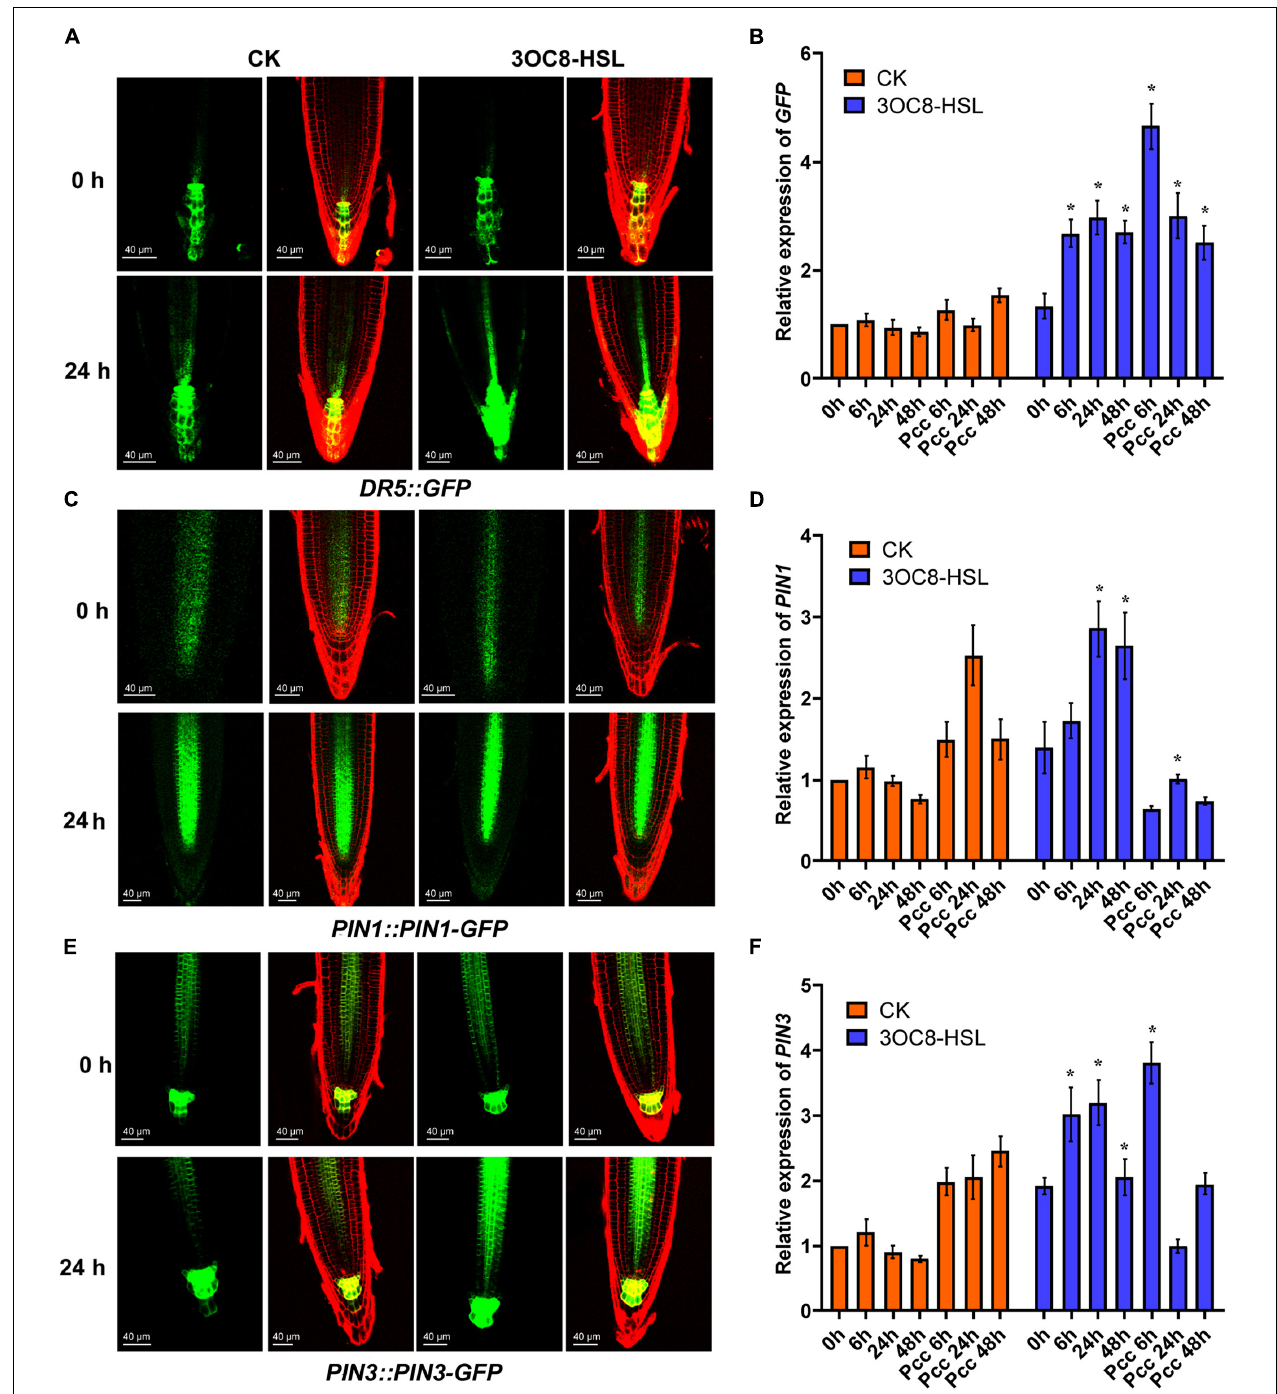
FIGURE 6 | AHL-induced expressions of auxin response gene DR5 , auxin transport gene PIN1 and PIN3 . (A,C,E) GFP fluorescence of primary roots (PR), in 5-d-old DR5::GFP , PIN1::PIN1-GFP, PIN3::PIN3-GFP seedlings exposed to 10 µ M 3OC8-HSL for 24h. DR5::GFP auxin response is increased in QC. Cell walls were stained with PI. We performed the experiment 5 times and 30 roots each treatment. The left panels show the GFP fluorescence, on the right is the merged image of PI stained cell wall with GFP fluorescence. (B,D,F) Expressions of GFP , PIN1 , PIN3. At least five independent experiments were performed, each of which with three technical repeats. Asterisks indicate a statistically significant difference between the AHL-pretreated and the water-treated plants (ANOVA test, * P < 0.05). Values are means ± SD of five independent experiments.